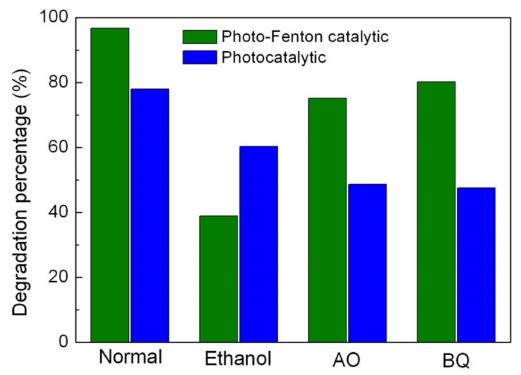
Figure 10. Effects of ethanol, benzoquinone (BQ) and ammonium oxalate (AO) on the photocatalytic and photo-Fenton catalytic degradation rates of MO over 15% Ag 2 S/BiFeO 3 under visible-light irradiation.